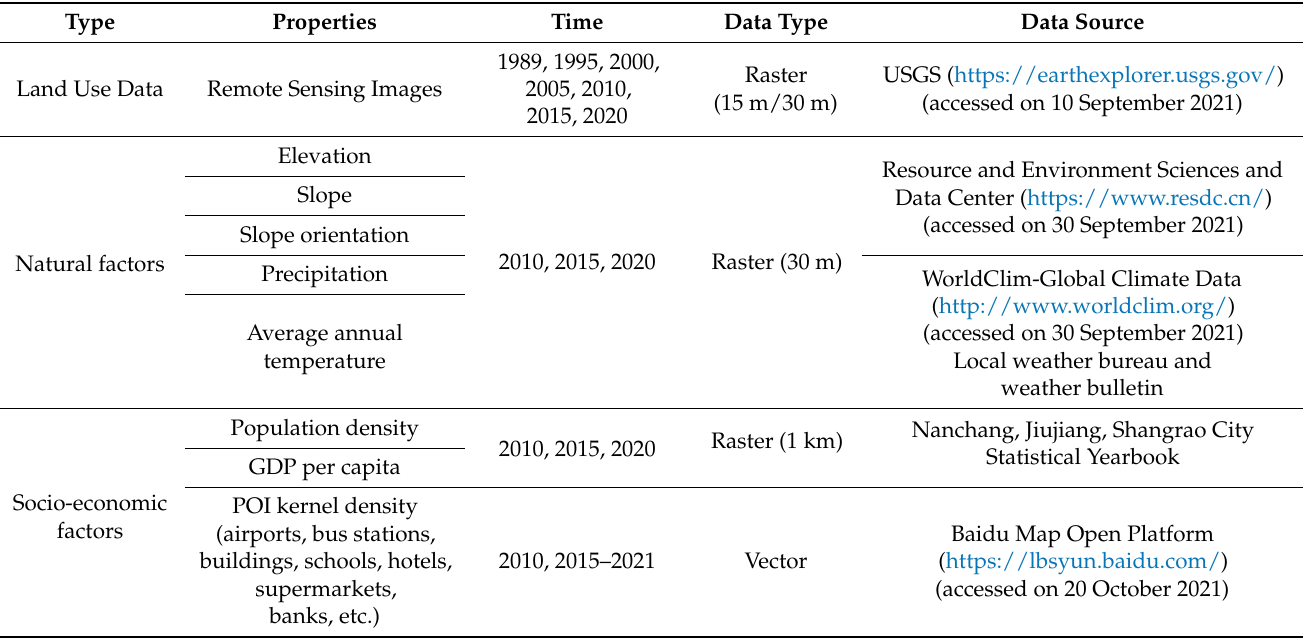
Table 1. List of data and